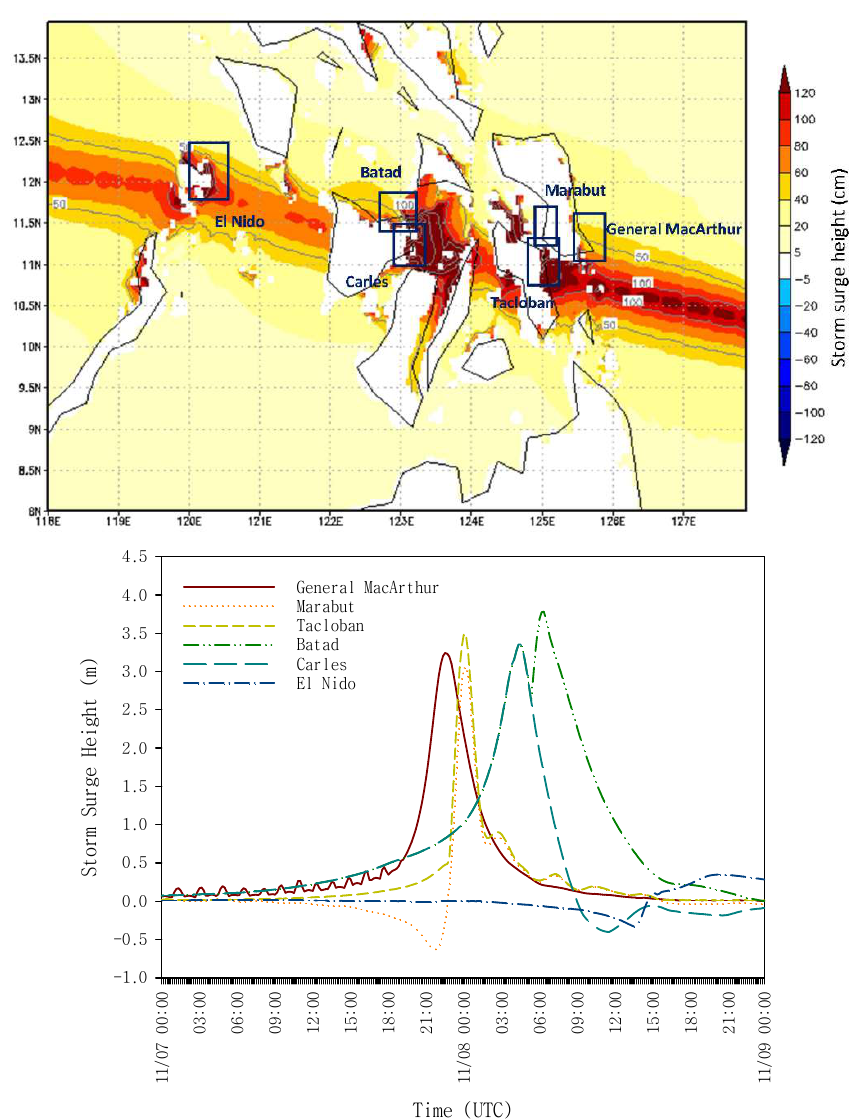
Figure 2. Most affected coastal areas ( upper panel ) and their respective simulated storm surge time series results ( lower panel ).